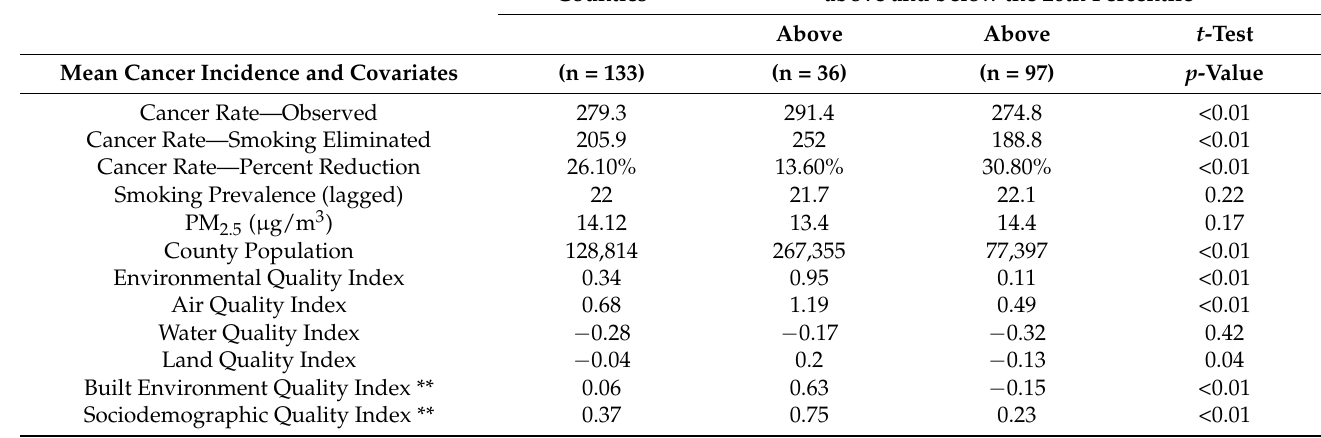
Table A1. Incidence rates of 12 smoking-related types of cancer in 133 SEER metropolitan counties, 2016, as observed and assuming smoking elimination, and covariates restricted to counties with smoking prevalence close to the mean. All Metropolitan Counties with Post-Smoking Elimination Incidence Rates Counties above and below the 20th Percentile